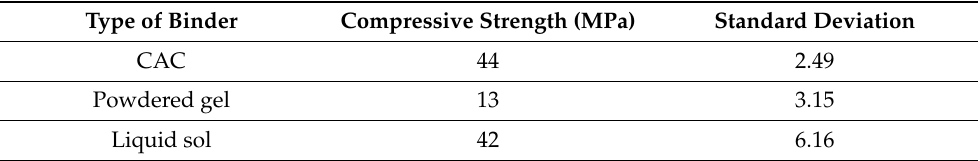
Table 3. Compressive strength of concrete samples with various type of